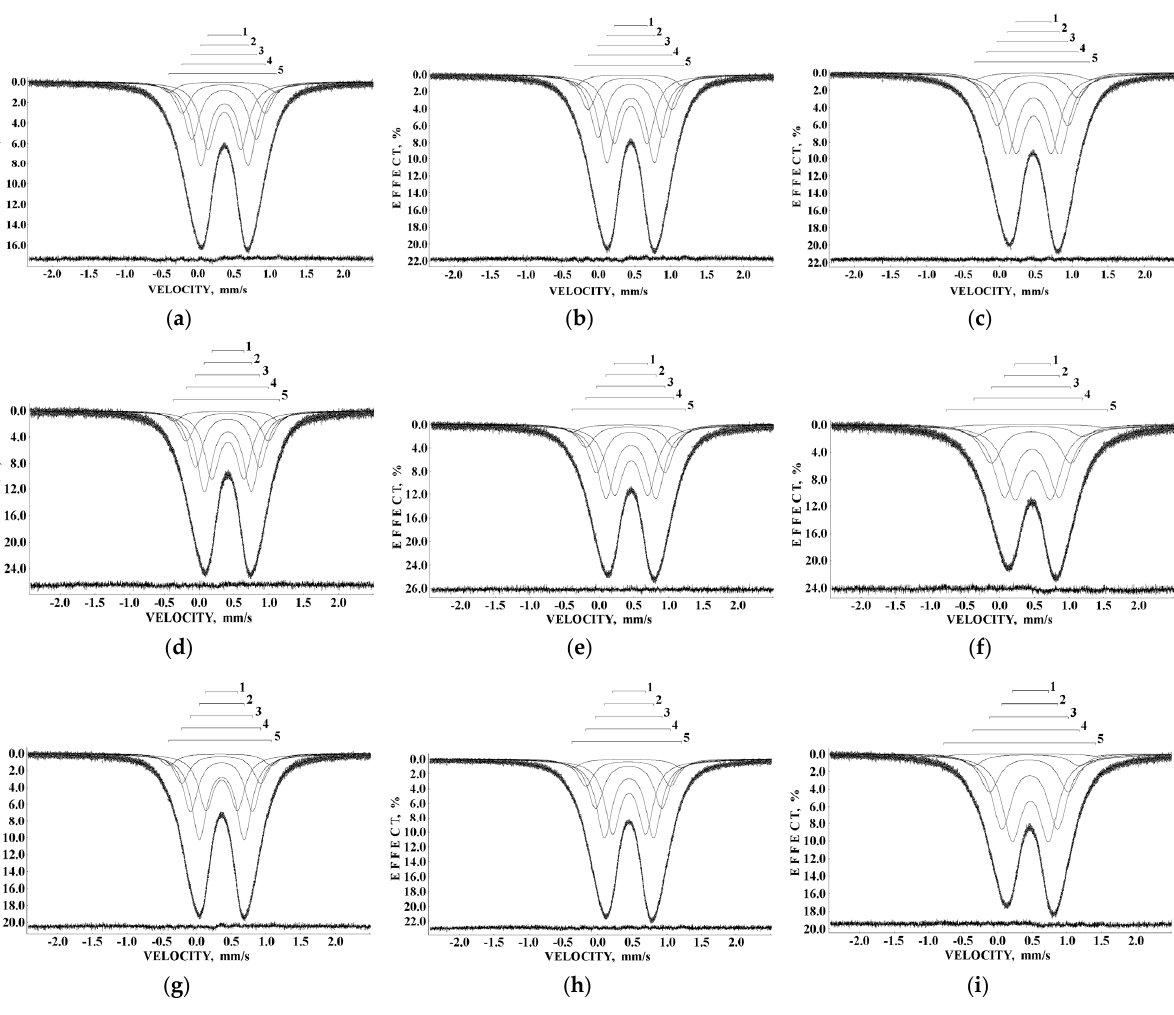
Figure 23. Selected Mössbauer spectra of Ferrum Lek ( a – c ), Maltofer ® ( d – f ) and Ferrifol ( g – i ) measured with a high velocity resolution in 4096 channels at different temperatures: 295 K ( a ), 170 K ( b ), 105 K ( c ), 220 K ( d ), 125 K ( e ), 90 K ( f ), 295 K ( g ), 140 K ( h ) and 98 K ( i ). These spectra were fitted within the new heterogeneous model for the iron cores (quadrupole doublets 1–5). The differential spectra are shown on the bottom. Adapted from Ref. [49] with permission from Elsevier: Spectrochimica Acta, Part A: Molecular and Biomolecular Spectroscopy, Vol. 172, Oshtrakh M.I.,